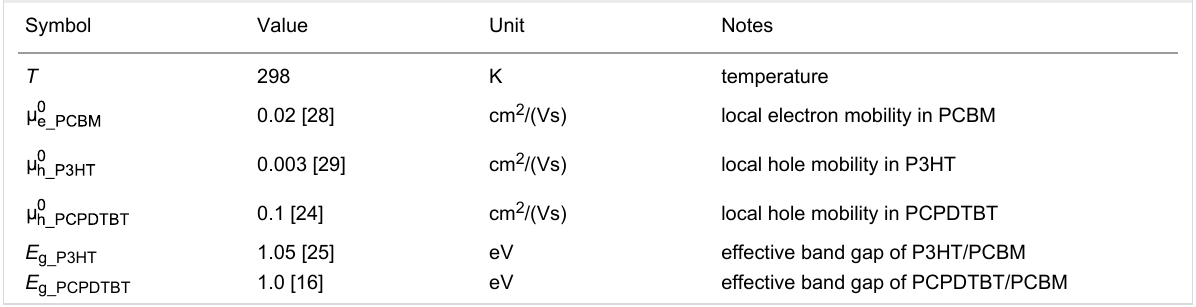
Table 1: The parameters used in the multiscale simulation. Symbol Value